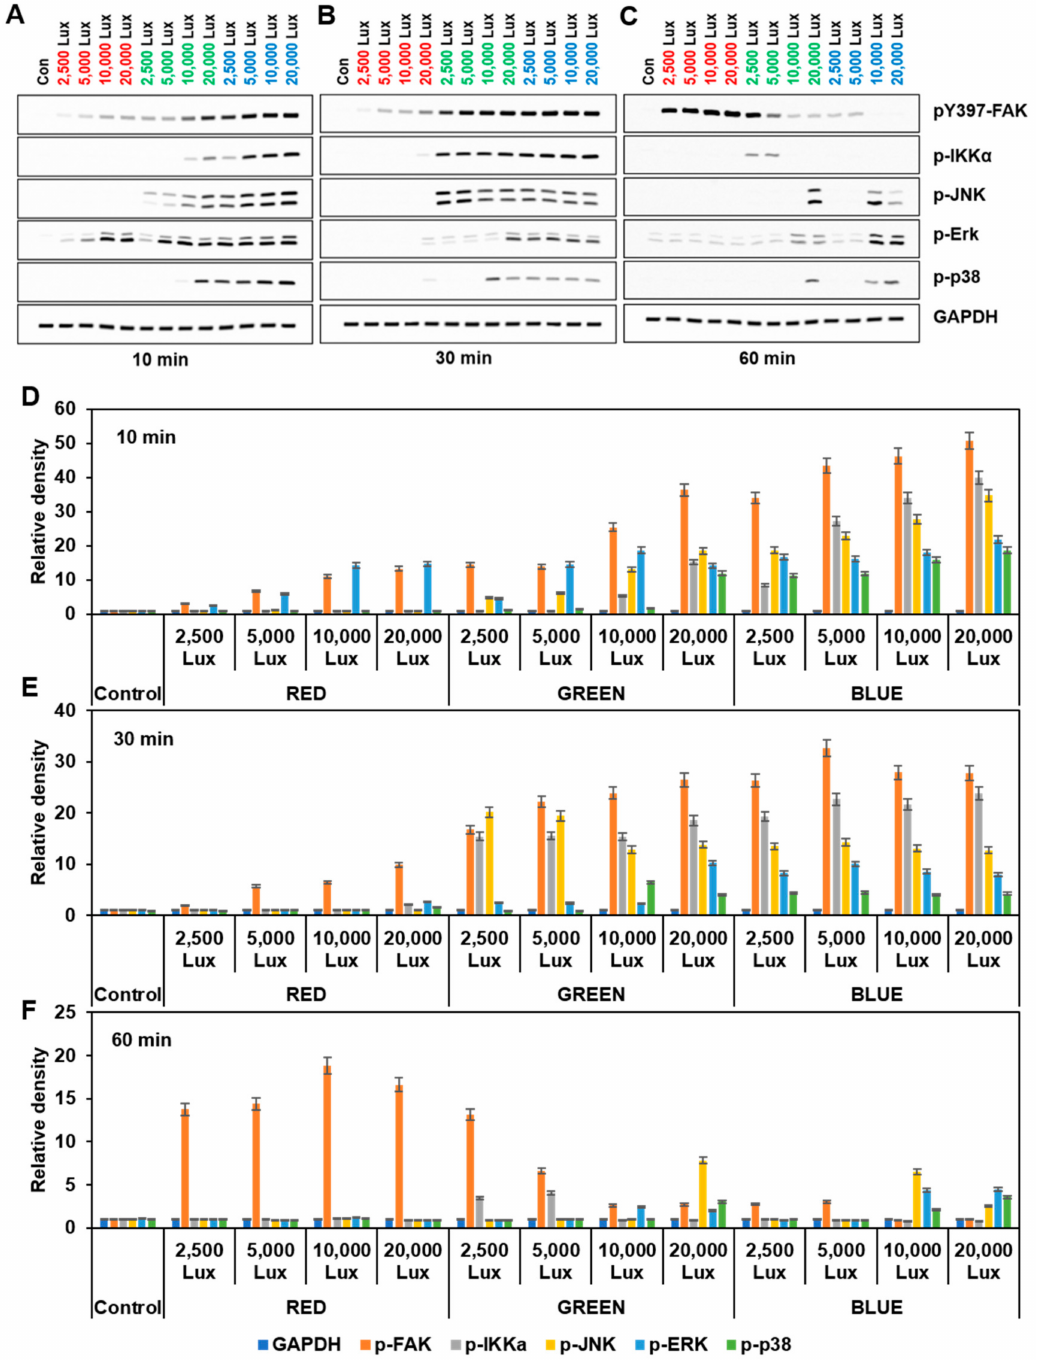
Figure 3. Effect of red, green, and blue LED lights on FAK and MAPK activation. HaCaT cells in a 6-well plate were exposed to the indicated LED lights for the indicated times. ( A – C ) Shown are immunoblots of pY397 FAK, p-IKK α , p-JNK, p-ERK, and p-p38, as well as GAPDH as a loading control. ( D – F ) Fold changes of pY397 FAK, p-IKK α , p-JNK, p-ERK, and p-p38 were calculated ( n = 3, ±